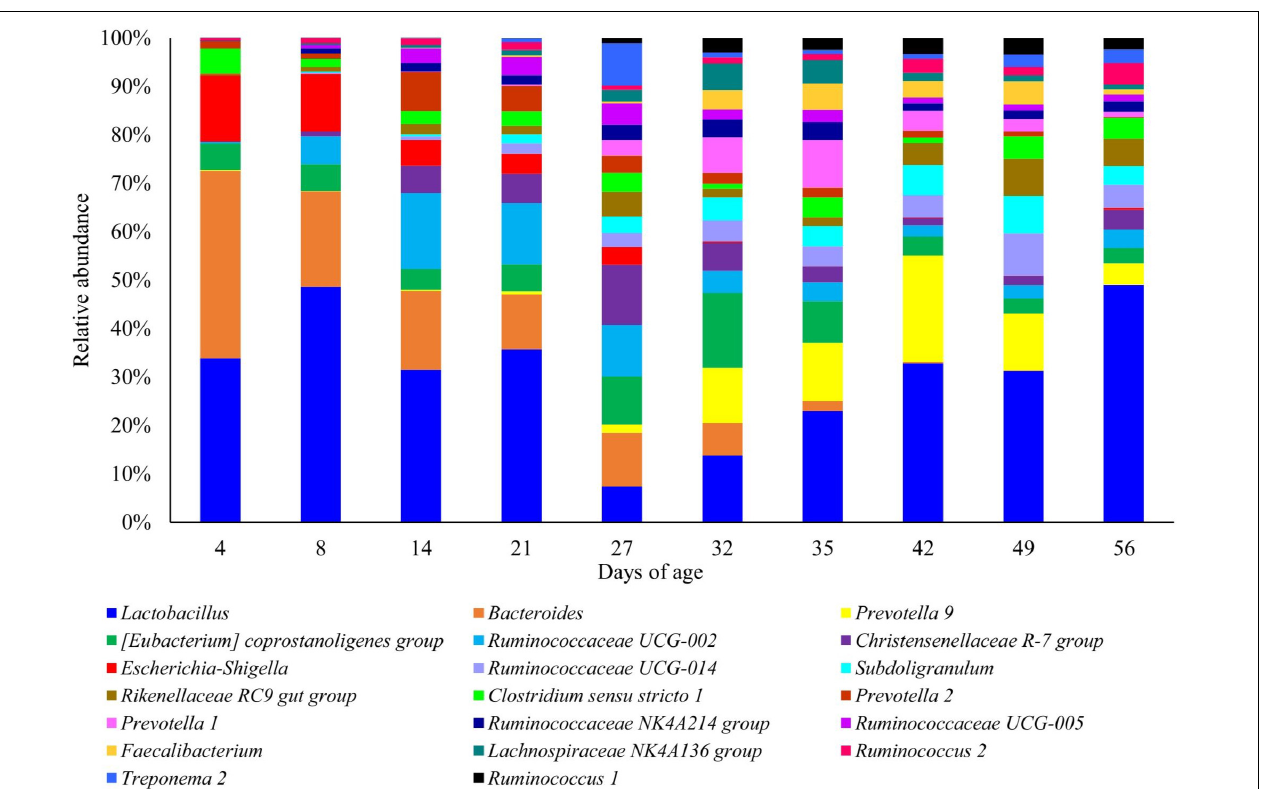
FIGURE 6 | Stacked bar plot of the mean relative abundances of the 20 most abundant classified genera at each piglet age. Relative abundances were rescaled to only account for the 20 most abundant